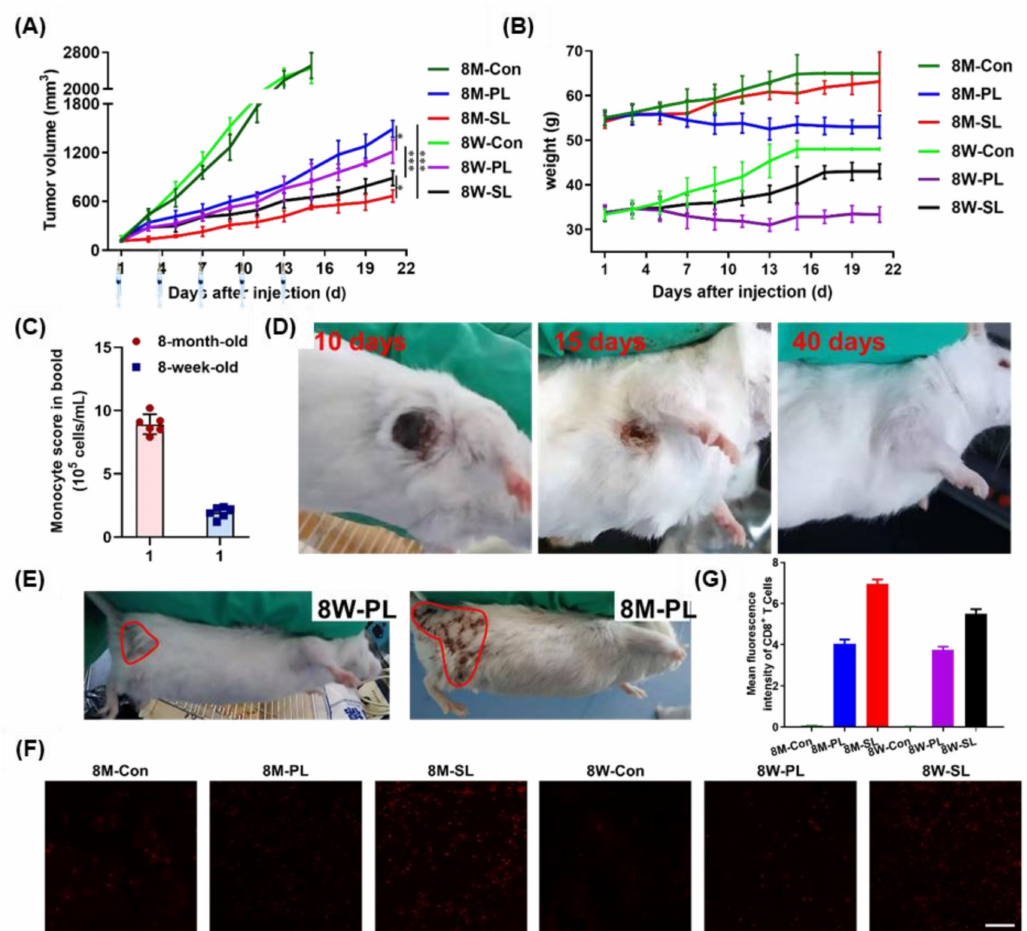
Figure 6. ( A ) Tumor volume of mice after completion of EPI-SL and EPI-PL treatment in tumor- bearing mice, n = 6, * p < 0.05, and *** p < 0.001. ( B ) Weight of mice after completion of EPI-SL and EPI-PL treatment in tumor-bearing mice, n = 6. ( C ) The number of PBMs in blood isolated from mice of different ages. ( D ) Tumor shedding of 8-month-old Kunming mice. ( E ) The area of hair shed between 8M-PL and 8W-PL. ( F ) The changes of CD8 + T cells in tumor in each treatment group, ( G ) and mean fluorescence intensity of CD8 + T cells (Scale bar = 100 µ